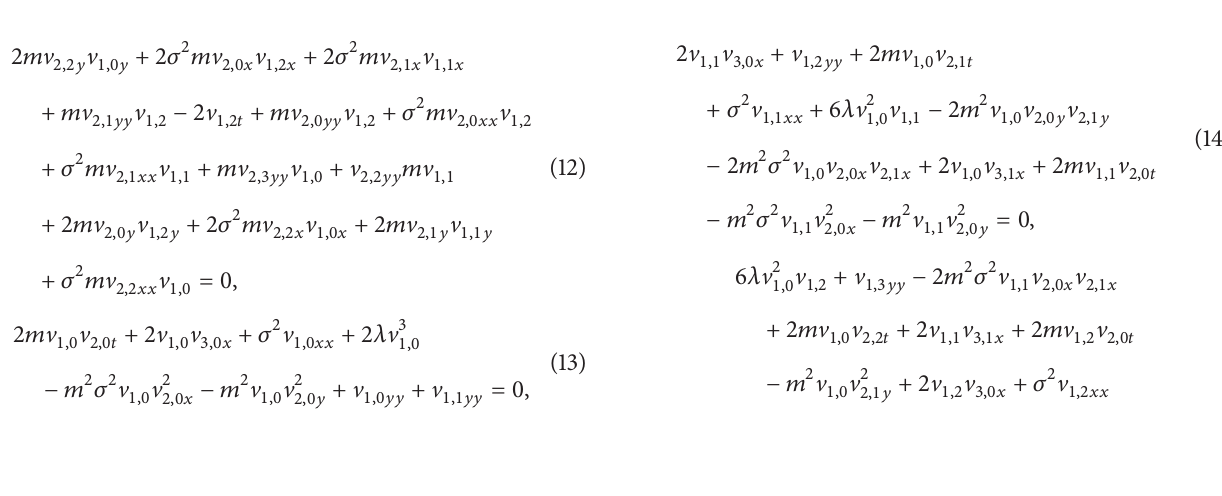
Figure 4: The results obtained by HPM and HAM for 𝜙(𝑥,𝑦,𝑡) , at 𝑡 = 0.2 in comparison with the exact